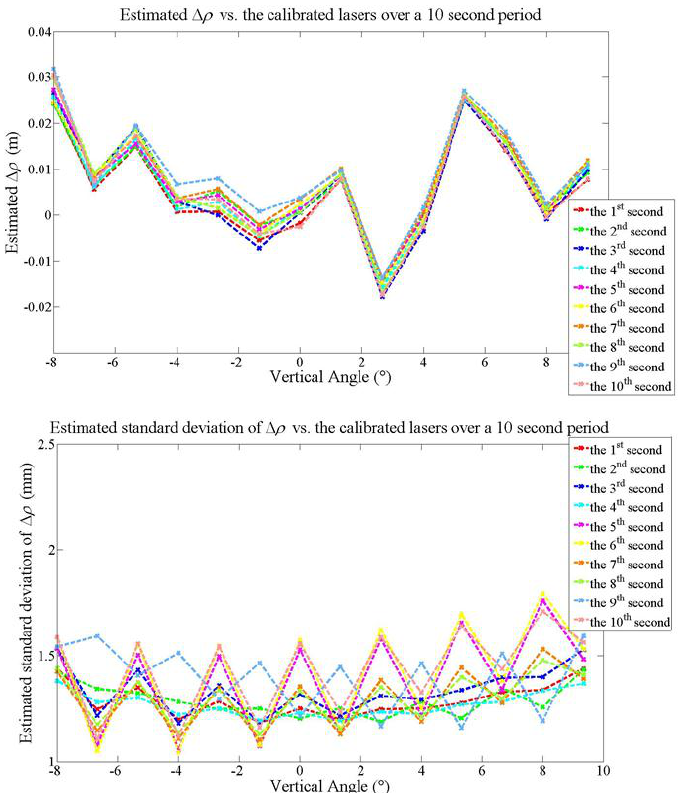
Figure 12. Estimated Δρ for Dataset 1 over a 10 second period (( a ) top). The standard deviations of estimated Δρ by the calibration for Dataset 1 over a 10 second period (( b ) bottom).